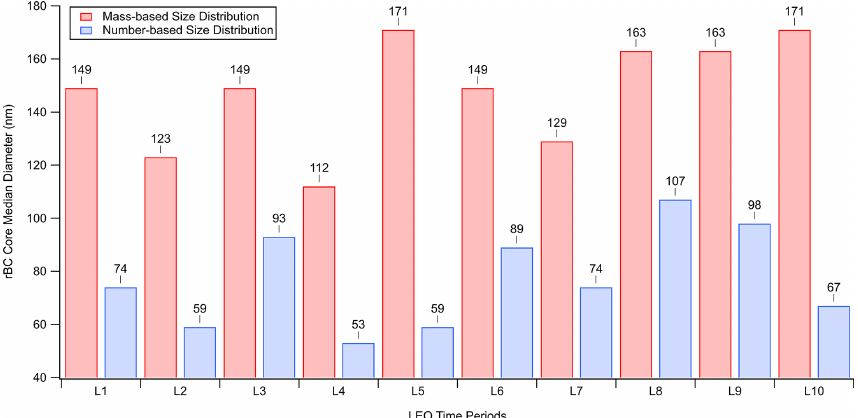
Figure 12. Median rBC core diameter for both the mass and number size distribution lognormal